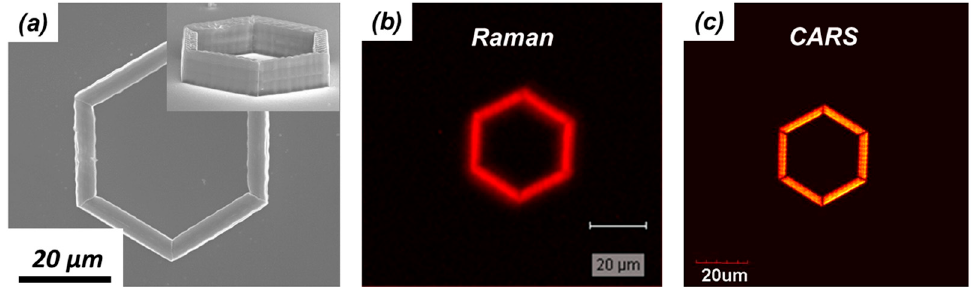
Figure 11. Image acquisition speed comparison between Raman confocal microscopy ( b ) and Coherent anti-Stokes Raman scattering (CARS) microscopy ( c ). Top and side SEM views of the TPP microstructure used in the test are shown in ( a ).